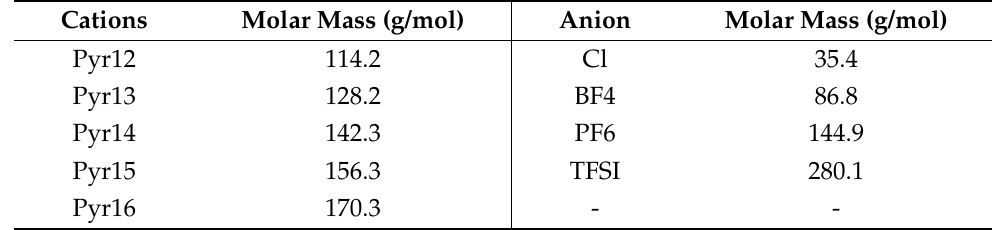
Table 1. Molar mass of cations and anions.